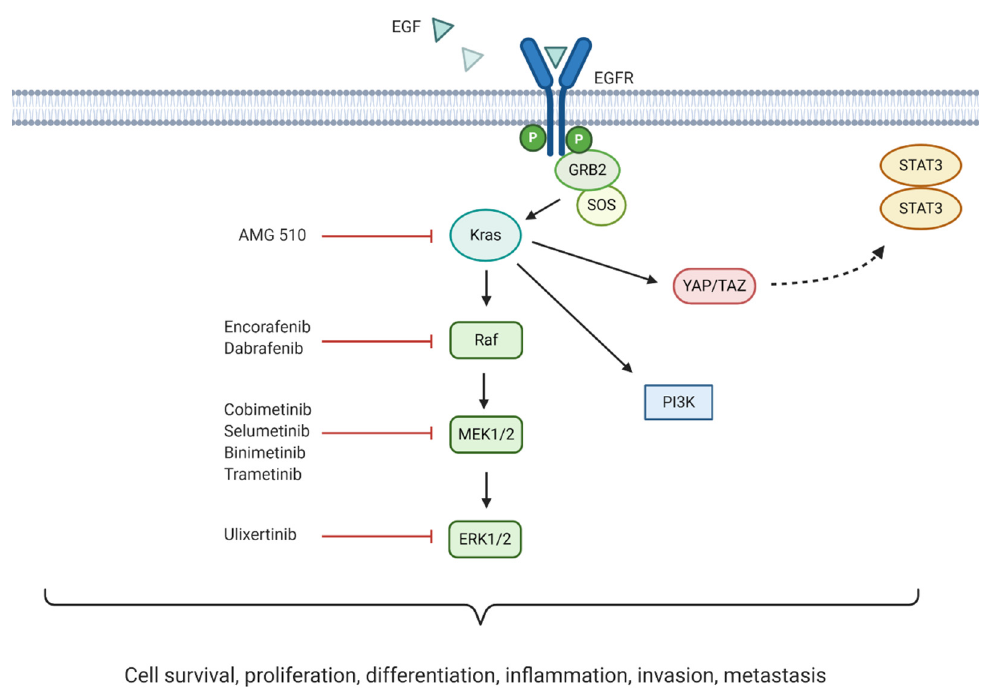
Figure 5. Mitogen-activated protein kinase (MAPK)/ extracellular signal-regulated kinase (ERK) pathway crosstalk, downstream effects, and inhibitors currently being trialled in pancreatic cancer treatment.